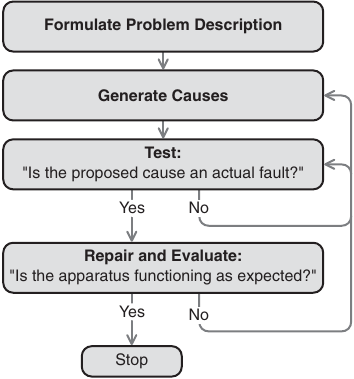
FIG. 1. Cognitive troubleshooting tasks. These tasks describe the iterative process of repairing a malfunctioning